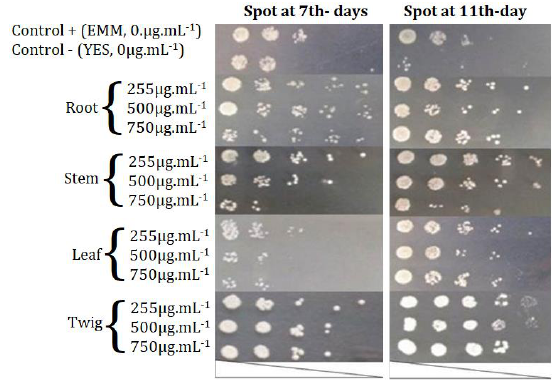
Figure 1. The effect of phytoextracts derived from the vegetative organ parts of X. granatum on the